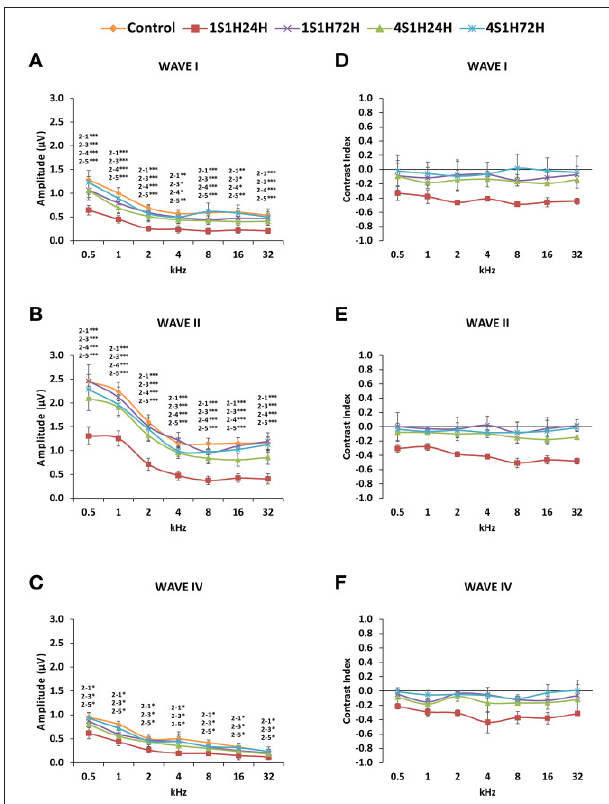
FIGURE 3 | Line graphs showing the amplitudes (in µ V) and contrast index of waves I, II, and IV plotted as a function of frequencies in control and experimental animals. Before sound stimulation, wave amplitudes were larger in the lower frequencies and smaller at medium and higher frequencies, being wave II the largest of all (A–C) . However, by 24h after the first session there was a significant decrease in all waves amplitudes (A–C) , with contrast indexes below − 0.2 in all waves and at all frequencies (D–F) . The amplitudes (A–C) as well as the contrast index (D–F) were recovered by the fourth session. Stimulus intensity = 80dB SPL. (1) Control; (2) 1S1H24H; (3) 1S1H72H; (4) 4S1H24H; (5) 4S1H72H. * p < 0.05 ; ** p < 0.01 ; *** p < 0.001 .